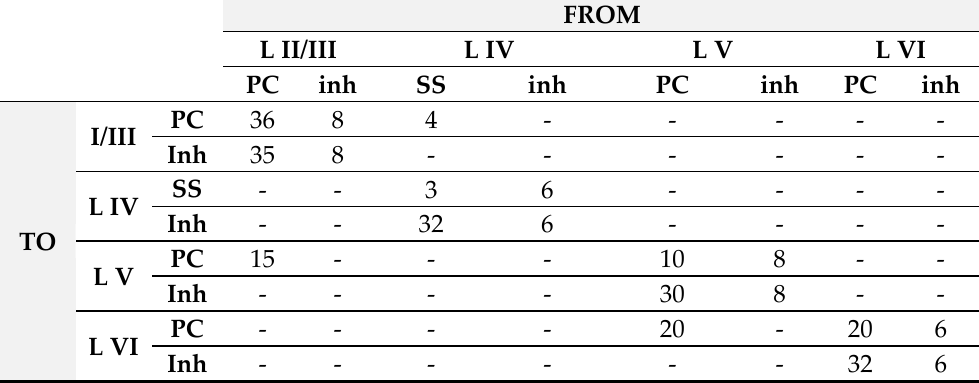
Biology 2021 , 10 , x FOR PEER Table 3. Connectivity parameters of the computational model implemented (indegree per postsynap-